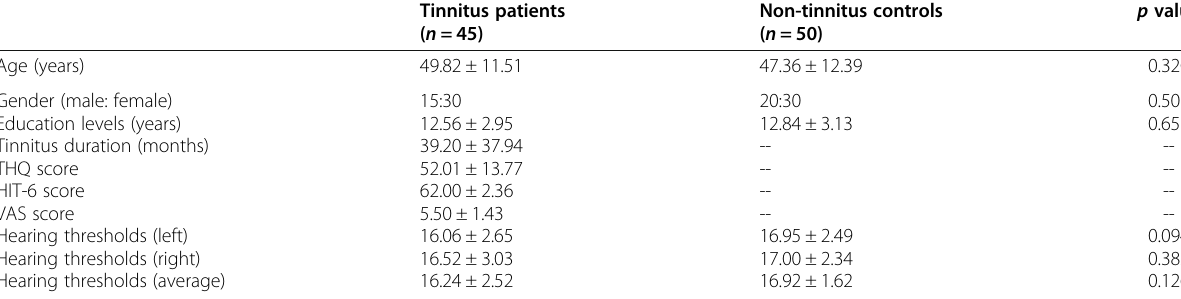
Table 1 Demographic and clinical characteristics of tinnitus patients and non-tinnitus controls